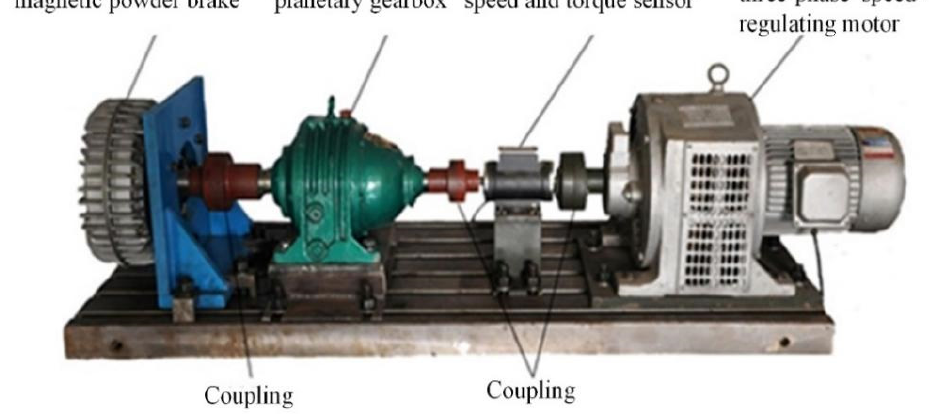
Figure 5. Schematic diagram of the planetary gearbox experimental platform.